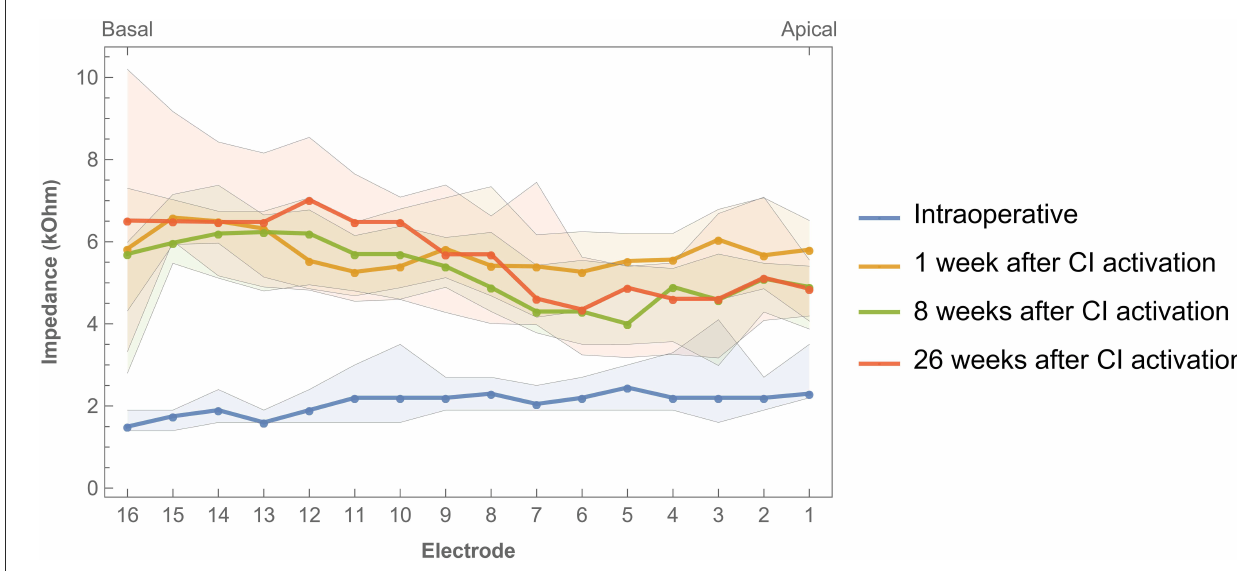
FIGURE6 Impedances across the electrode array were measured intraoperatively and during three return visits within the first 6 months of CI rehabilitation. Bands indicate the first and third